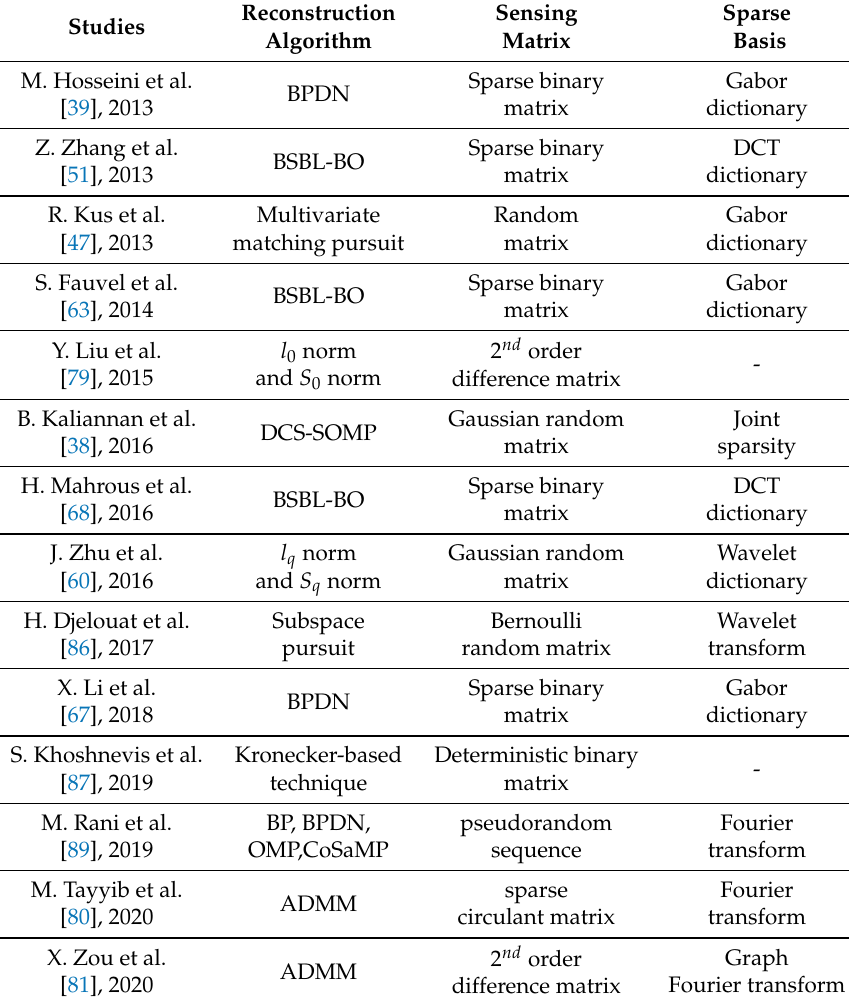
Table 2. A summary of CS applied EEG studies (signal reconstruction